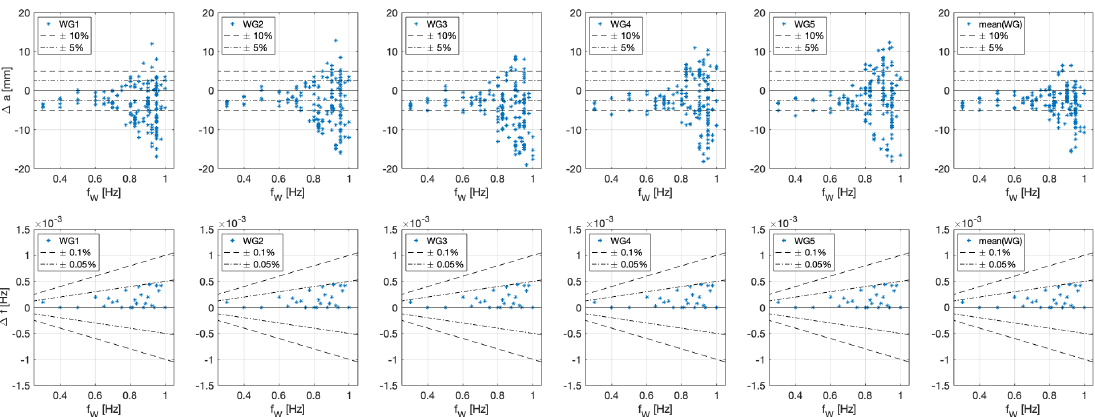
Figure 3. Analysis of the five individual wave gauge (WG) data, as well as the mean value conducted for the wave amplitude ( upper row ) and frequency ( lower row )—difference ∆ a = a R − a W (measured amplitude minus the requested amplitude); similar for the